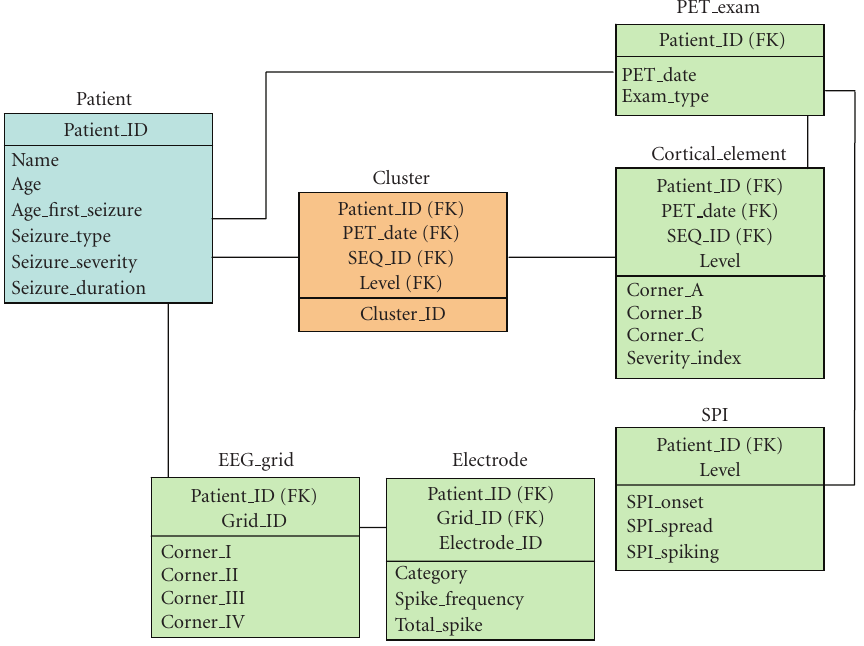
Figure 5: Relational model design of the database. On a conceptual level, the database is structured in three hierarchical levels. At the lowest level (green), PET and EEG information are stored, which is associated with distinct finite cortical elements. At the intermediate level (orange), functionally or electrophysiologically similar cortical elements are grouped into clusters. Finally, all clinical data characterizing the disease state are stored at the highest level (blue). For simplification of presentation, each three-dimensional coordinate is recorded as one attribute in tables, like Corner A in table